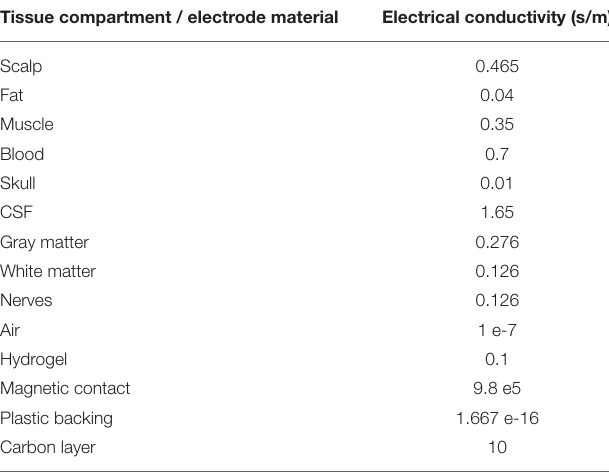
TABLE 3 | Assigned electrical conductivities. Tissue compartment / electrode